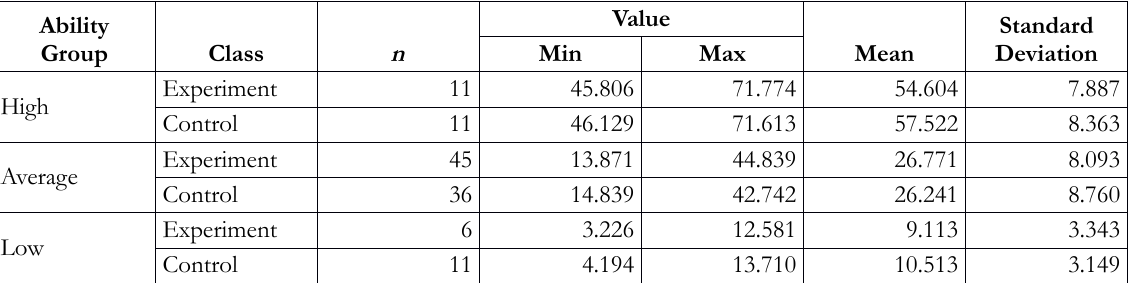
Table 2. Descriptive Statistic of Students’ Mathematical Initial Ability Group